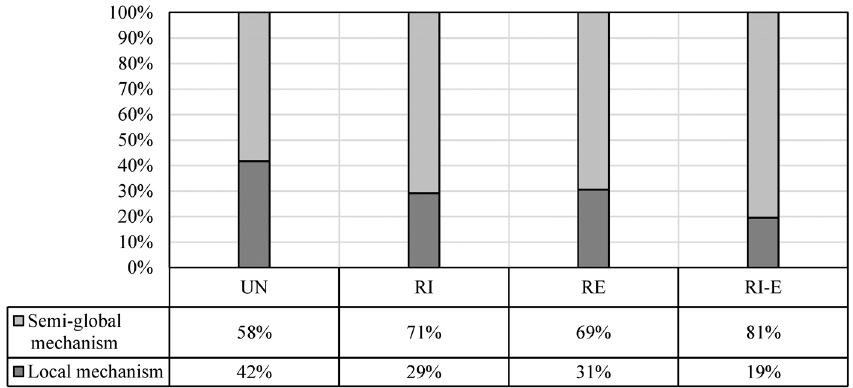
Figure 16. Percentage of activation of Local or Semi-global mechanisms in (UN), (RI), (RE) and (RI-E) buttressed arches.